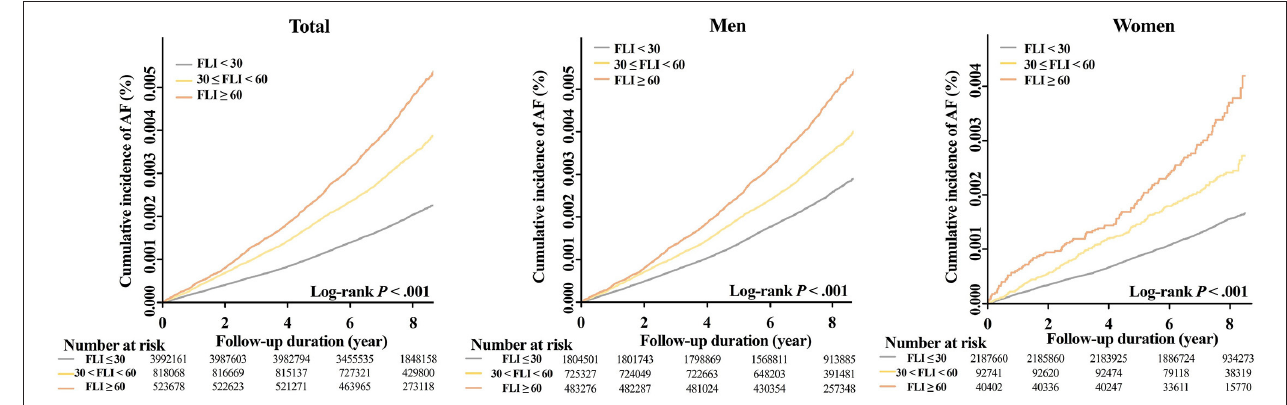
FIGURE 3 | Cumulative incidence curves of AF stratified by FLI group in total, men, and women. AF, atrial fibrillation; FLI, fatty liver index.